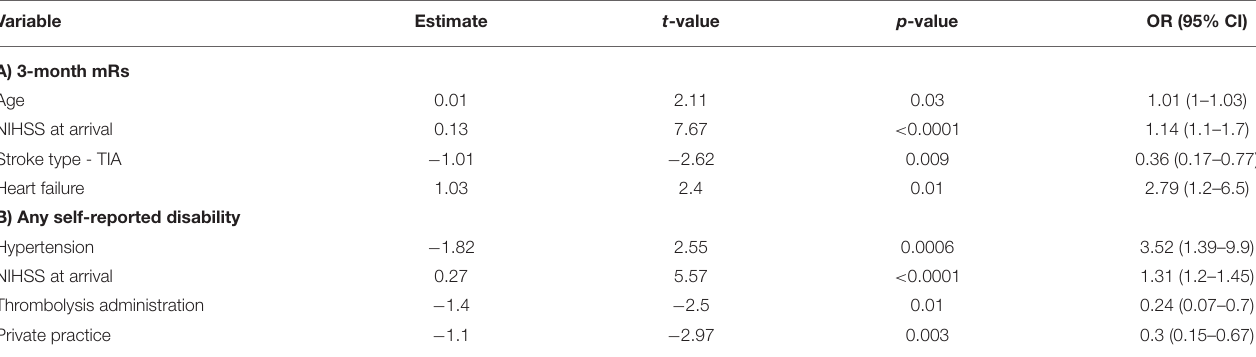
TABLE 3 | Multivariate regression model showing independent predictors of poor outcome at 3-months. Variable Estimate t -value p -value OR (95%